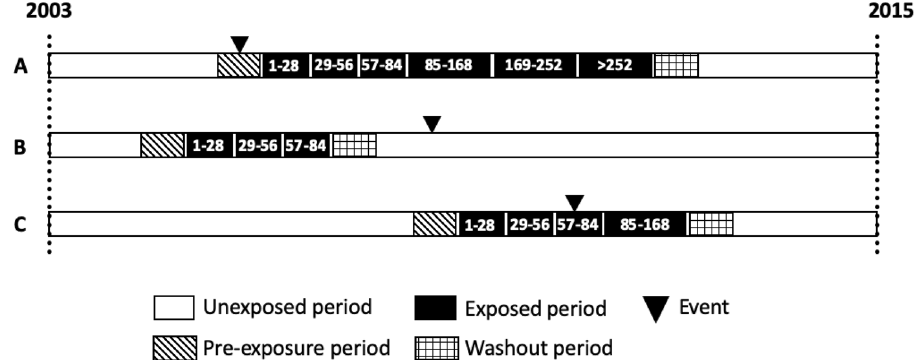
Figure 1. The bi-directional SCCS design of the study presenting all defined